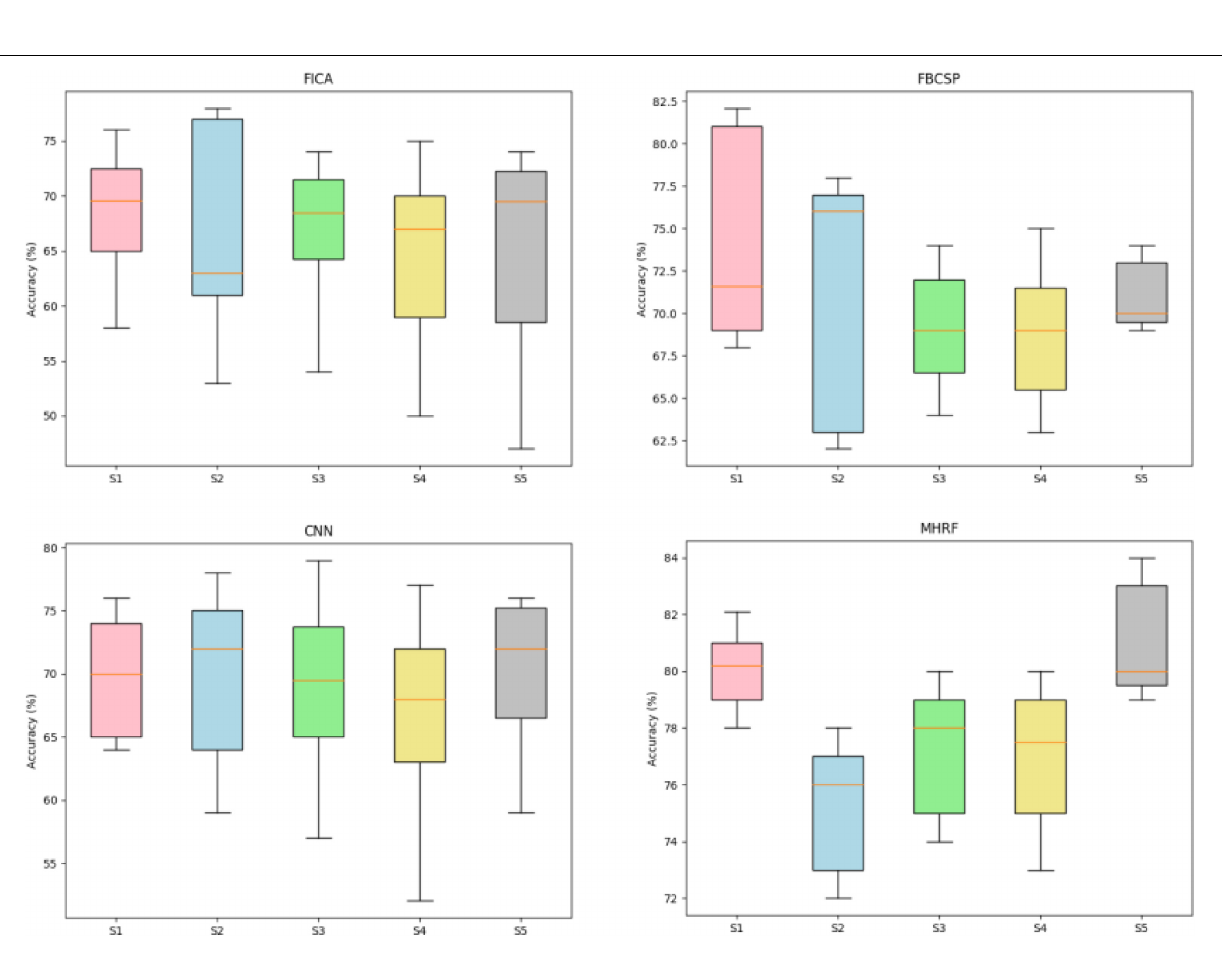
Frontiers in Neuroscience |